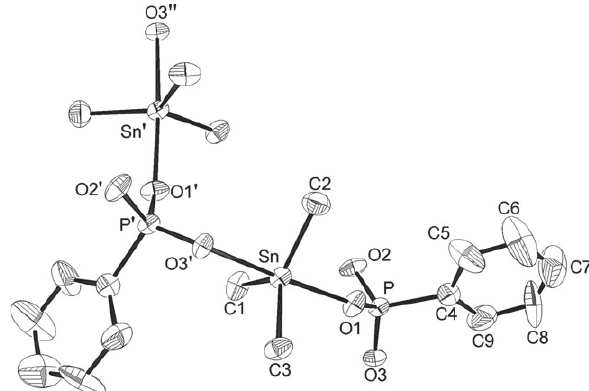
Figure 1 Zigzag infinite chain of [SnMe H atoms and the second component of the disordered phenyl ring have been omitted for clarity. Symmetry codes: ( ’ ) 1/2- x, y -1/2, 1/2- z ( ″ ) x, y -1/2; displacement ellipsoids are drawn at the 50% probability level.